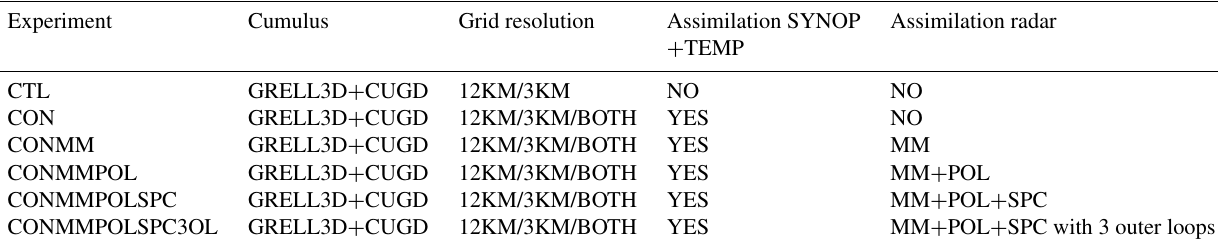
Table 2. List of experiments to test the impact of data assimilation.